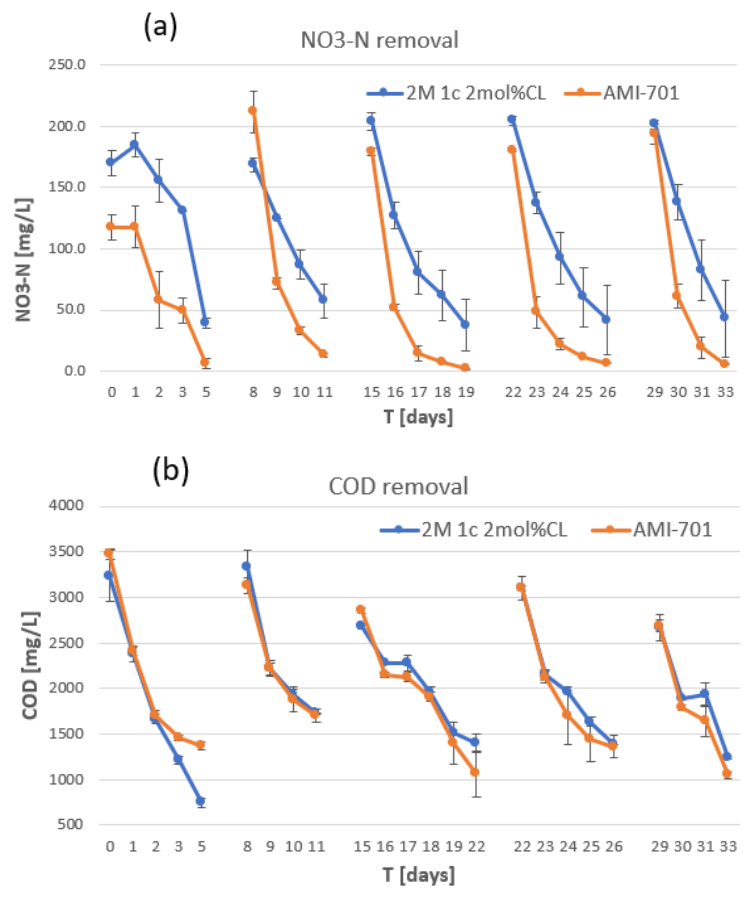
Figure 8. Nitrate and organic removal using electrotrophic denitrification system ( a ) Nitrate-nitrogen (NO 3 − -N) in cathode chamber and ( b ) organics (chemical oxygen demand) in anode chamber removal using our AEM 2 M 1c 2 mol%CL (blue) and AMI-7001 (red) through 5 batch modes.